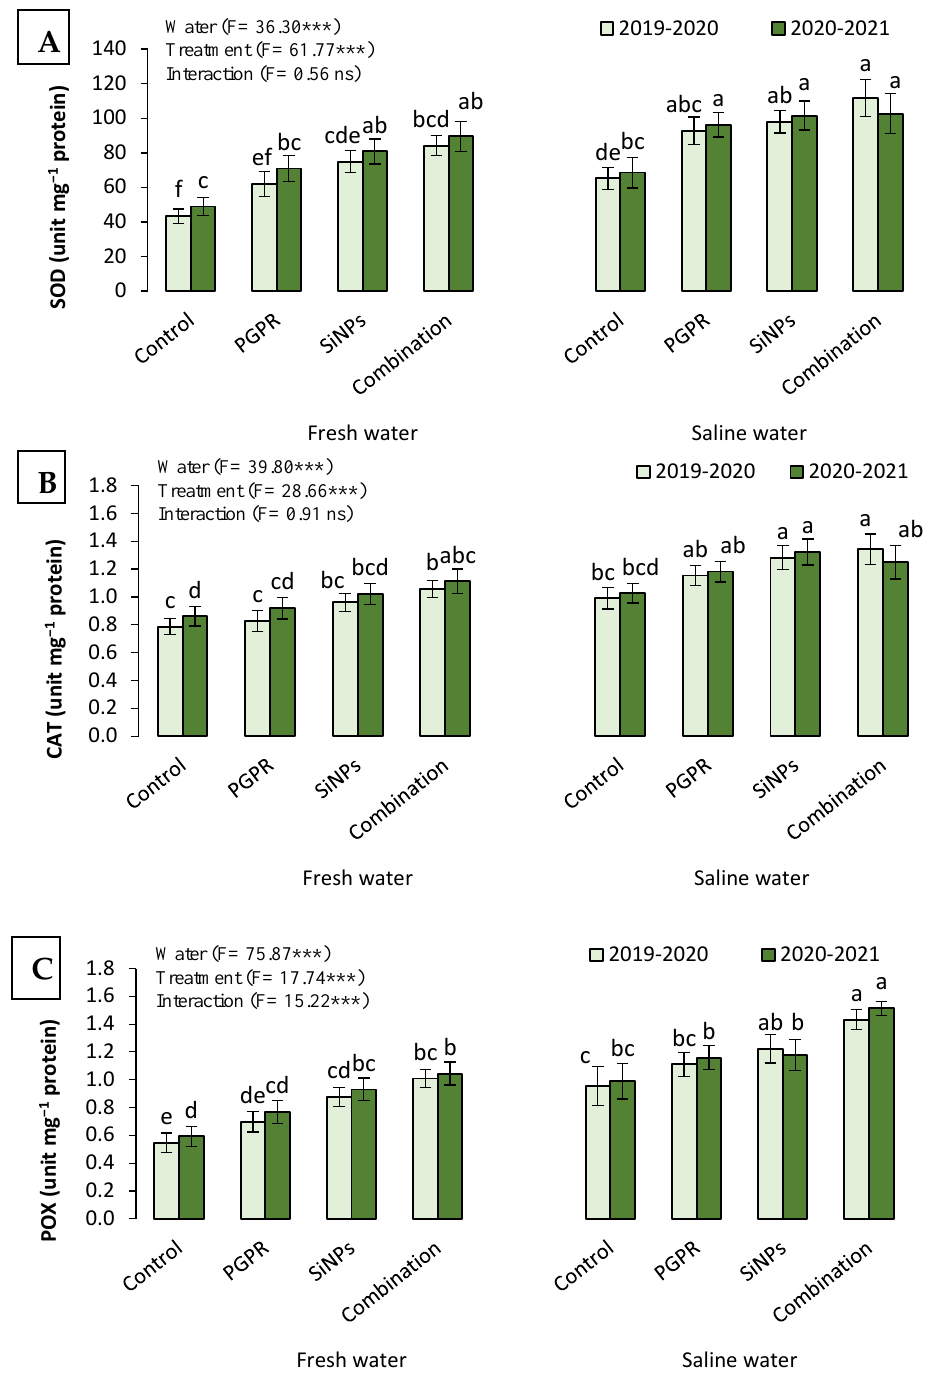
Figure 2. Response of different antioxidant enzymes: ( A ) superoxide dismutase (SOD); ( B ) catalase (CAT); and ( C ) peroxidase (POX) in barley ( Hordum vulgare L., cv. Giza 132) leaves, which was cultivated in salt-affected soil and treated with plant growth-promoting rhizobacteria (PGPR; Azotobacter chroococcum SARS 10 and Pseudomonas koreensis MG209738), silica nanoparticles (SiNPs), and their combination to alleviate the detrimental impacts of saline irrigation water during two consecutive seasons. Different letters in the same columns of the same season are significant according to the Tukey’s test ( p ≤ 0.05). Two-way ANOVA was run to display the significant differences between types of irrigation water, treatments, and their interaction according to the Tukey’s test ( p ≤ 0.05). Data are the means ± SD and n = 3. *** denotes significance at p ≤ 0.001, ns denotes insignificant difference.